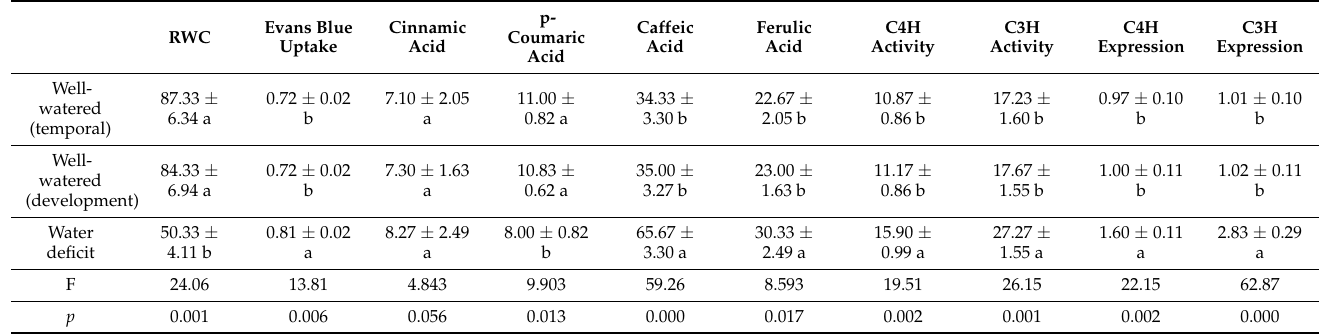
Table 1. Comparison of means of measured physiological, biochemical and molecular changes in maize grown in well-watered (temporal), well-watered (developmental) or water deficit